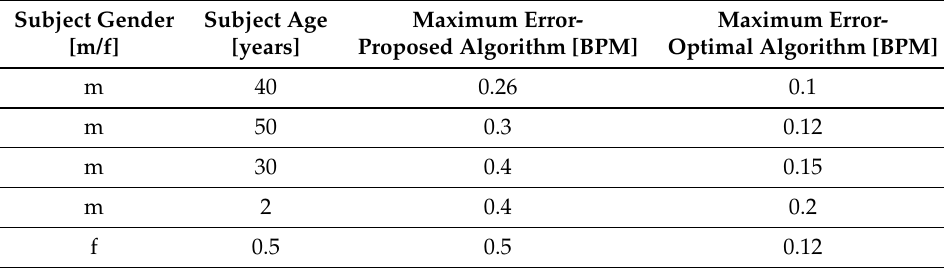
Table 2. Experiments